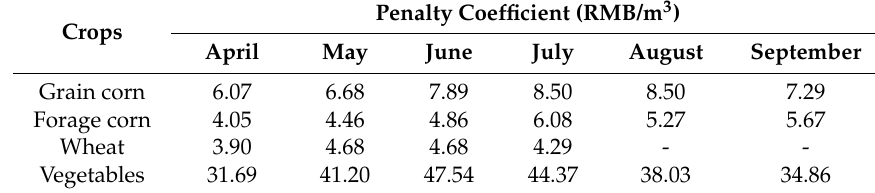
Table 5. Penalty